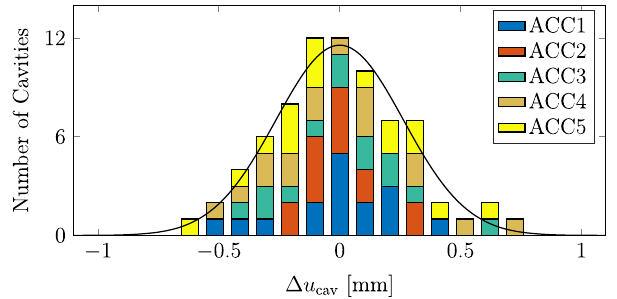
FIG. 17. Histogram of the fitted residual cavity offset Δ u with respect to the calculated module axis of the first five accelerating modules at FLASH. Both transverse planes are included. The fitted standard deviation is σ